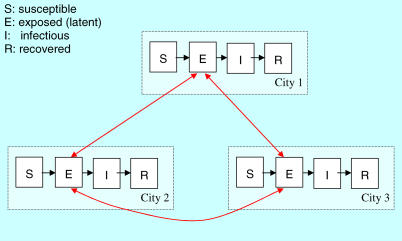
Schematic Illustration of Model Structure